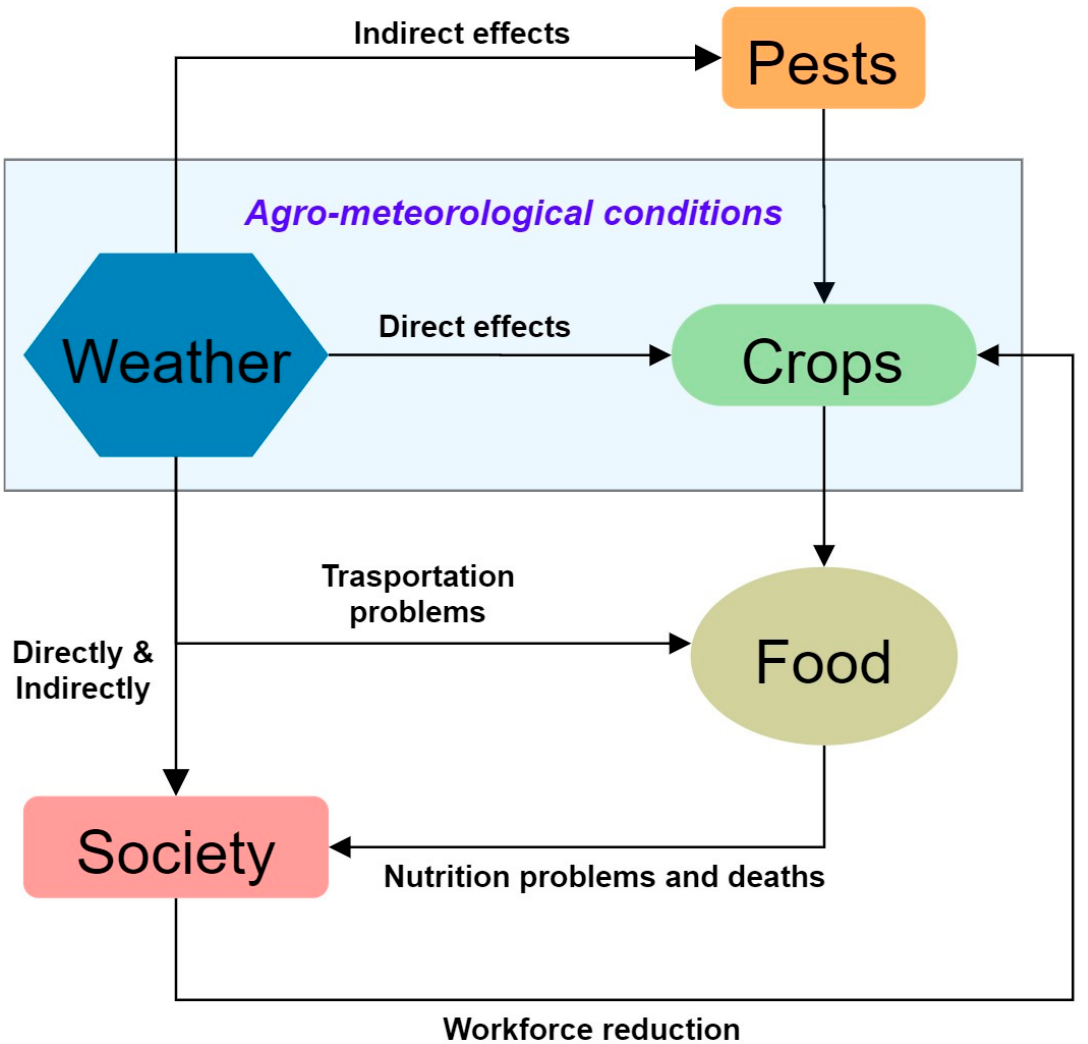
Figure 1. Flowchart depicting the linkage between weather, crops, food production, and